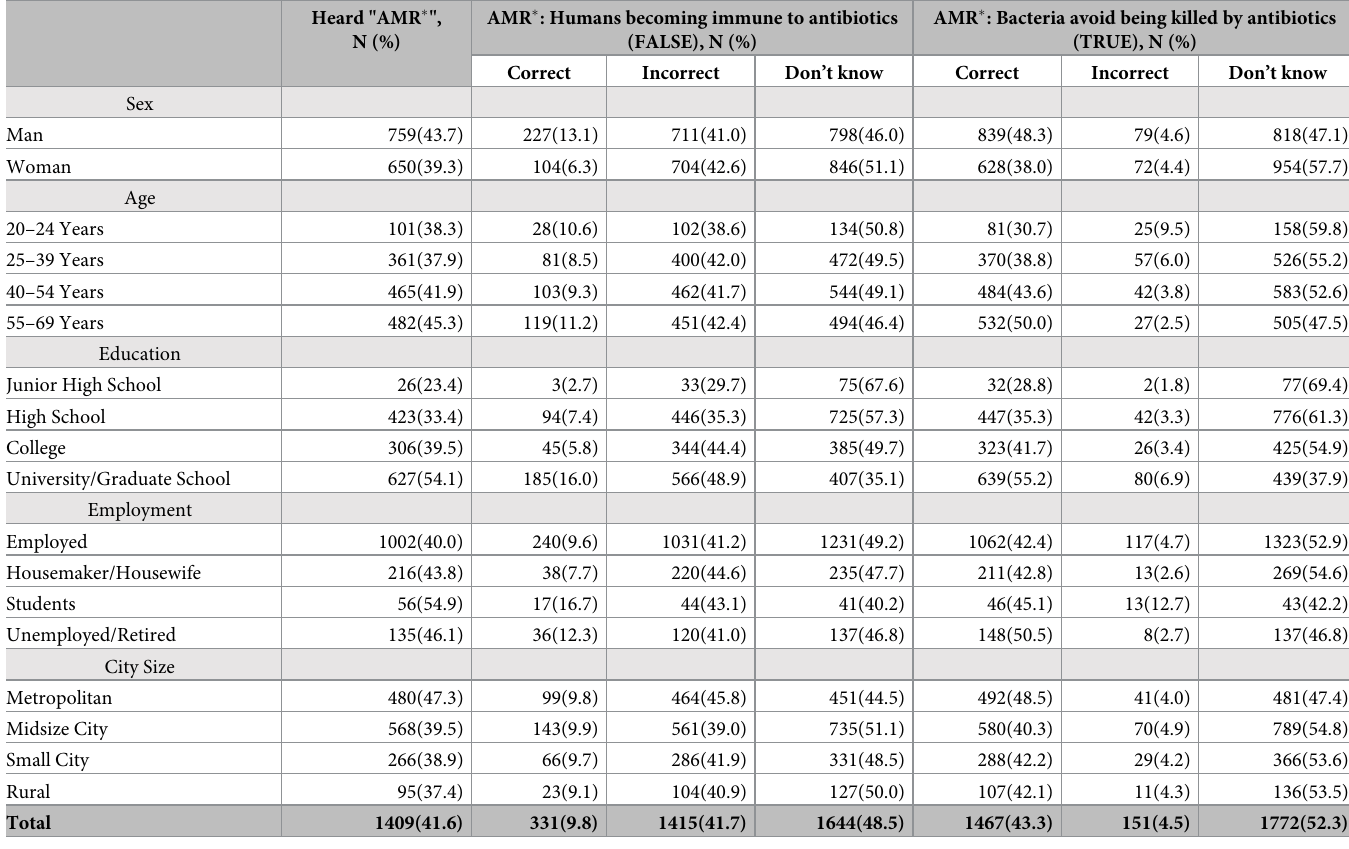
Table 5. Knowledge about antimicrobial